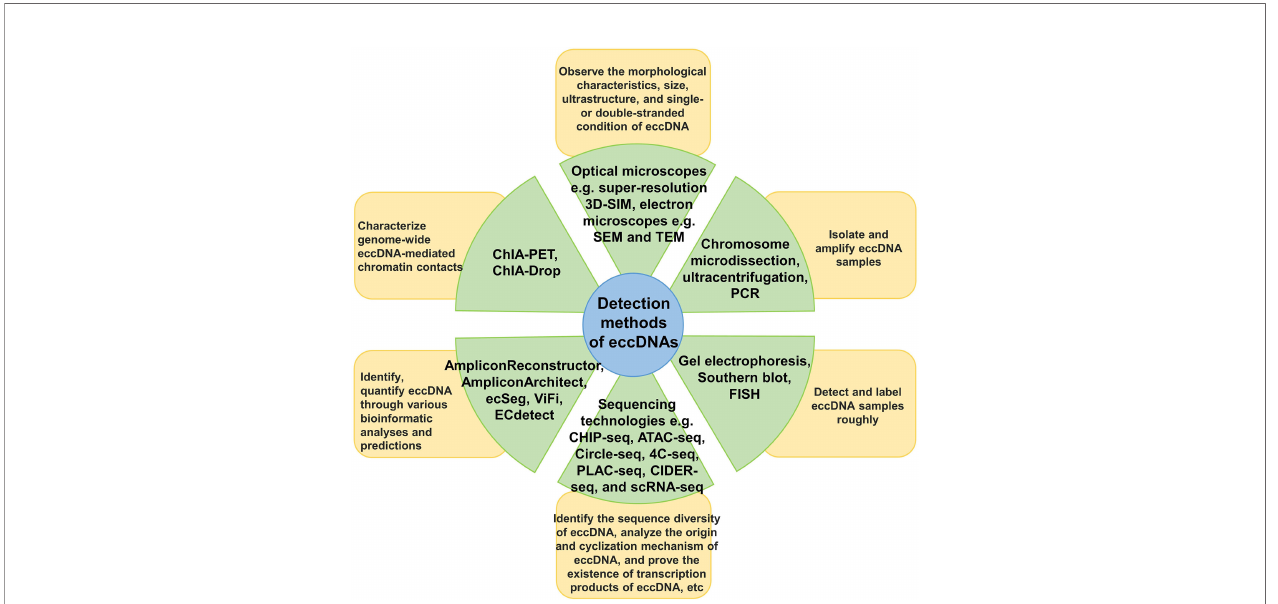
FIGURE 2 | Detection methods for eccDNA. The main research and detection methods for eccDNA are classi fi ed and described, as well as the use of each type of